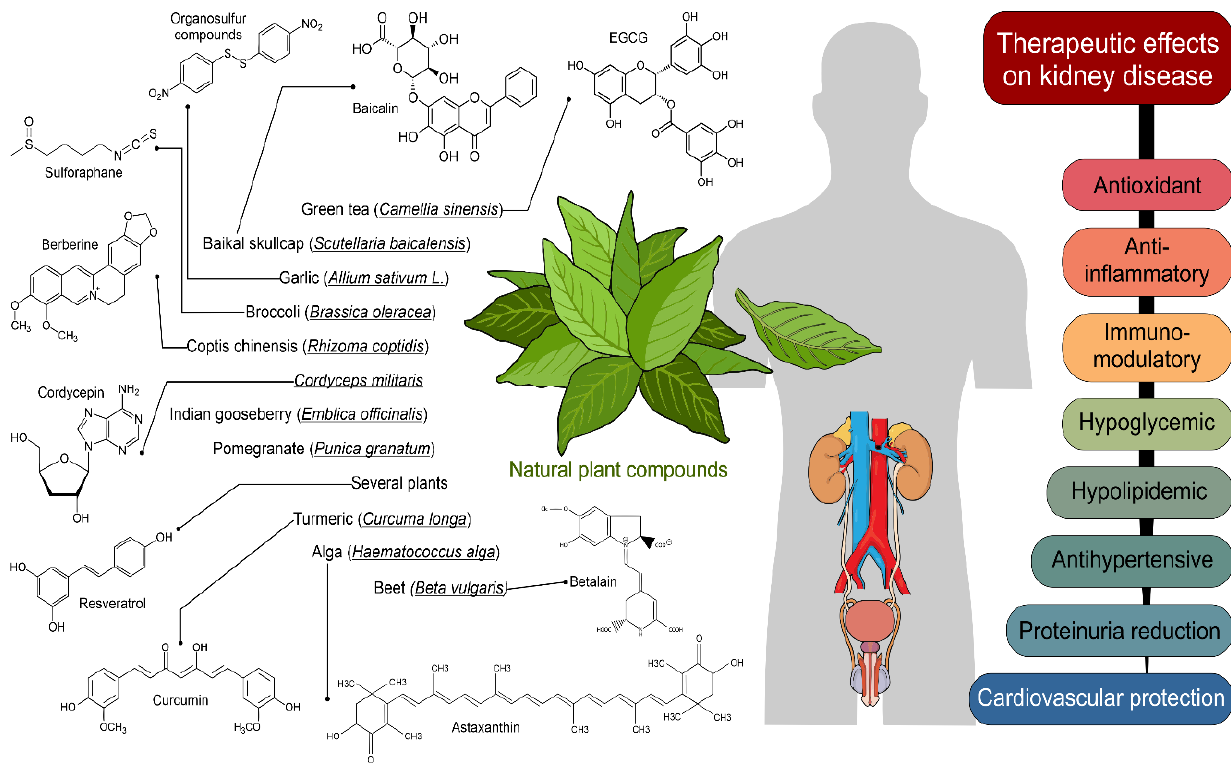
Figure 1. Therapeutic effects of natural plant compounds on kidney disease. Some elements of this figure were taken from the Mind the Graph platform, available at www.mindthegraph.com of access; 30 September 2021).